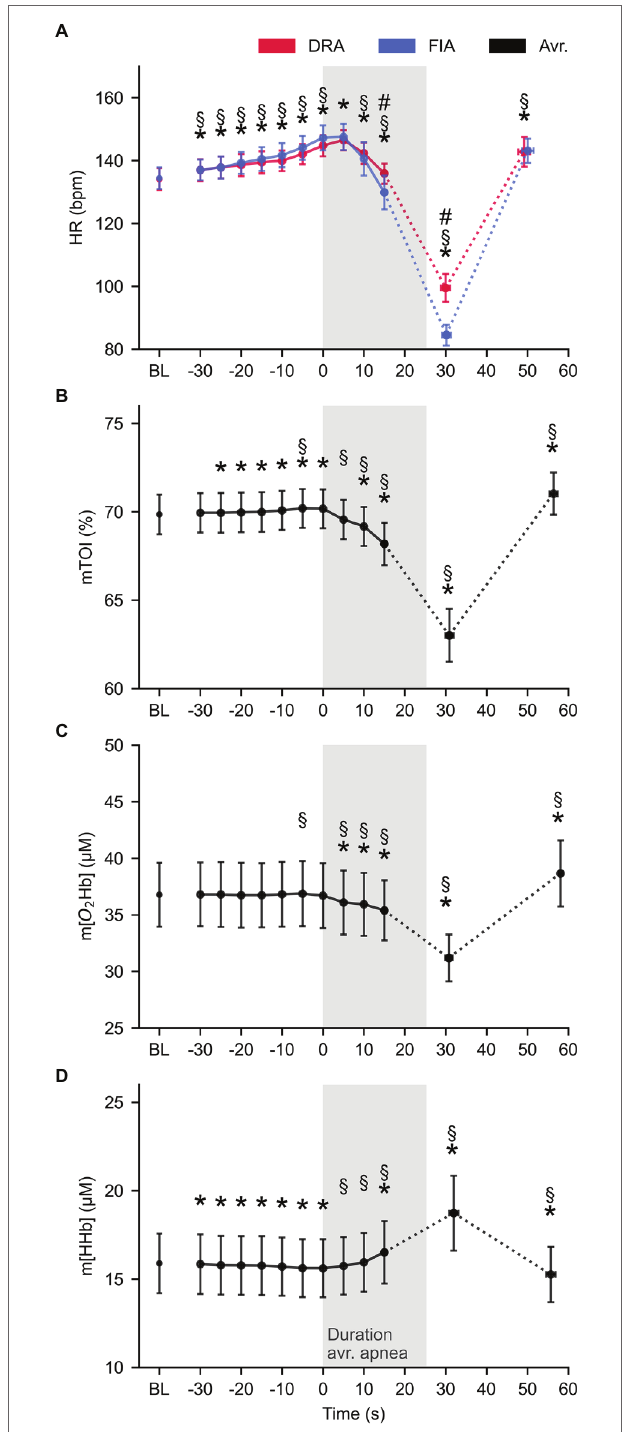
FIGURE 2 | The average pattern for heart rate (HR, panel A ), tissue oxygenation index (mTOI, panel B ), oxygenated (m[O2Hb], panel C ), and deoxygenated hemoglobin concentration (m[HHb], panel D ) during apnea ( n = 10). Blue lines represent FIA, red lines represent dynamic dry apnea (DRA), and black lines represent the average of both conditions. * = statistically different from BL at p < 0.05; § = statistically different from the previous value at p < 0.05; and # = statistical time × condition interaction effect at p <